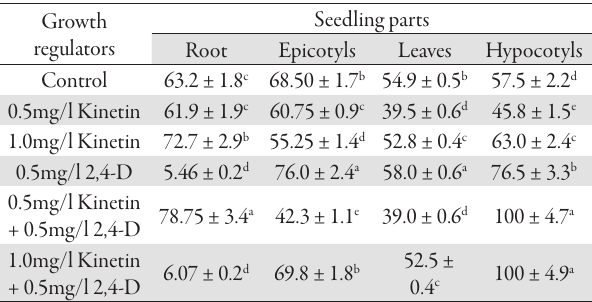
Tab. 1. Effect of different concentrations of kinetin and 2, 4-D as well as effect of some seedling parts on callusing